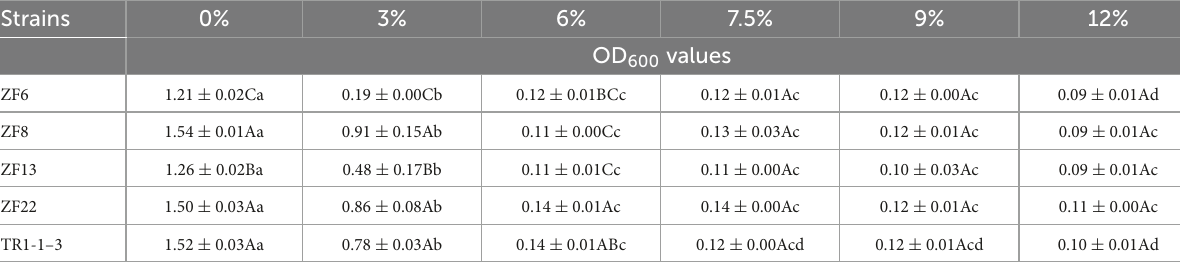
TABLE 1 Results of lactic acid bacteria tolerance to different salt